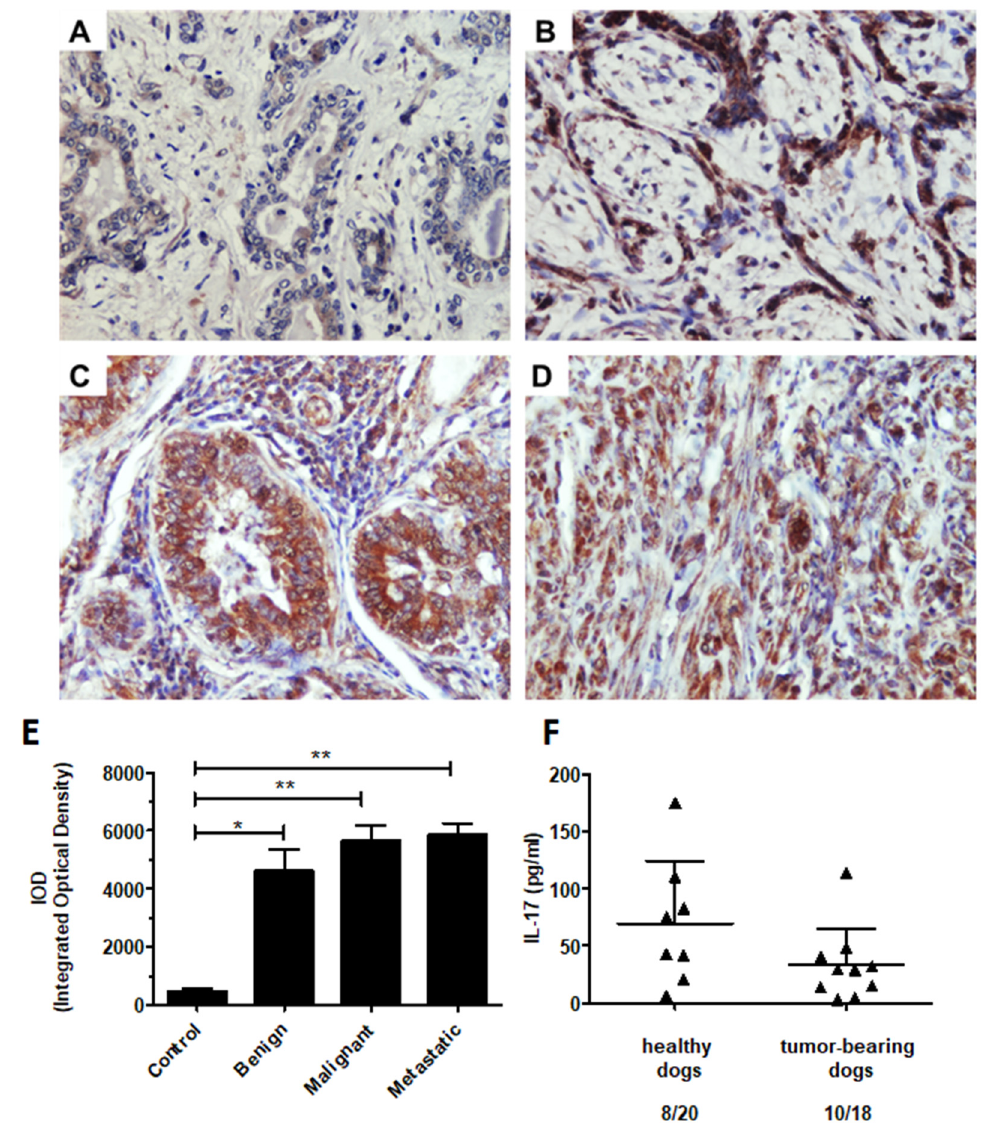
Figure 7. The immunohistochemical expression of IL-17 in canine mammary tumors and the plasma levels of IL-17 in healthy and mammary tumor-bearing dogs. Representative light micrographs of canine mammary gland tissue ( A ), benign ( B ), malignant ( C ), and metastatic tumors ( D ) obtained with an Olympus BX60 microscope (at 200 × total magnification). The IL-17 antigen is represented by the brown-colored precipitate in the cell cytoplasm and extracellular matrix. (E) The graph showing the IOD (integrated optical density) of IL-17 expression. The results are presented as the mean ± SEM. A one-way ANOVA and Tukey HSD post hoc test were applied. Significance levels are indicated as follows: * p < 0.05; ** p < 0.01. (F) The concentration of IL-17A (pg / mL) in the plasma of the client-owned healthy (8 out of 21) and malignant canine mammary tumor-bearing dogs (10 out of 18). Student’s t - test was applied, and no statistical significance was observed ( p > 0.05).